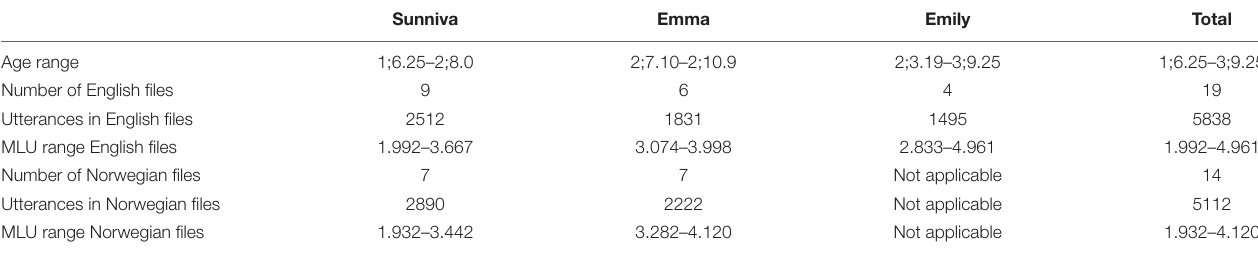
TABLE 1 | Overview of the data used in the study. Sunniva Emma